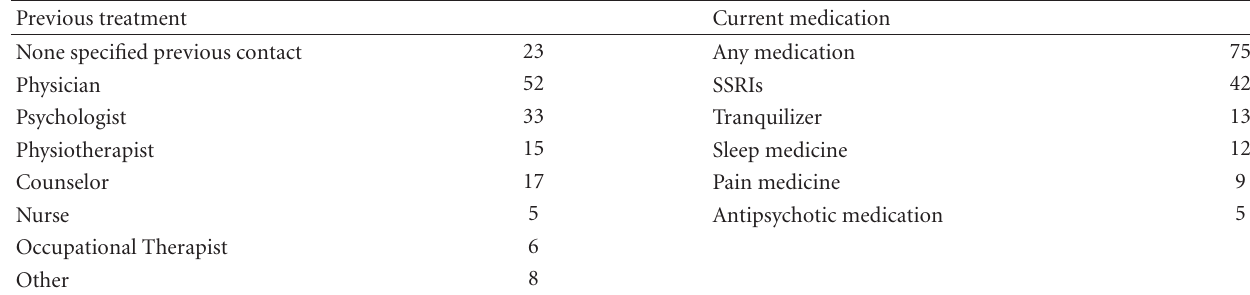
Table 3: Previous treatment and ongoing medication ( n = 94). Numbers are